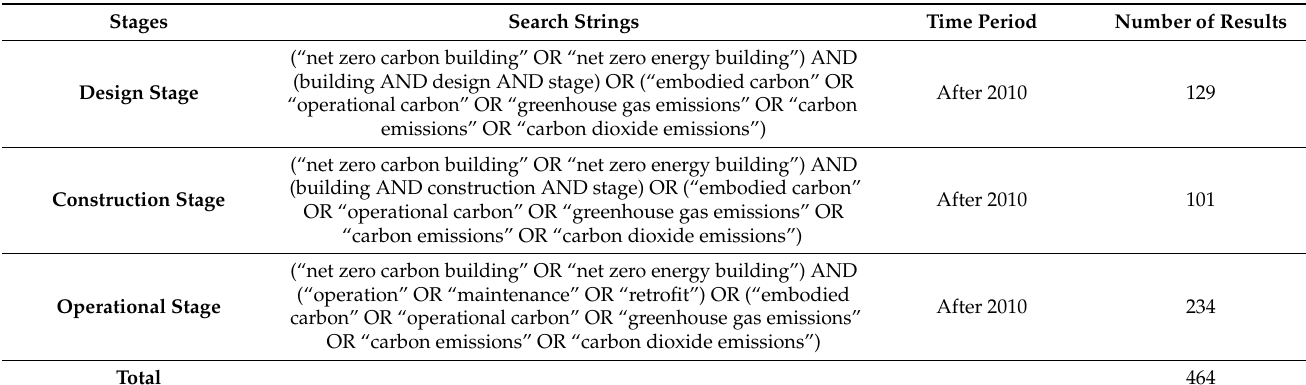
Table 1. Literature search results for key decision variables affecting whole-life-cycle net-zero- carbon